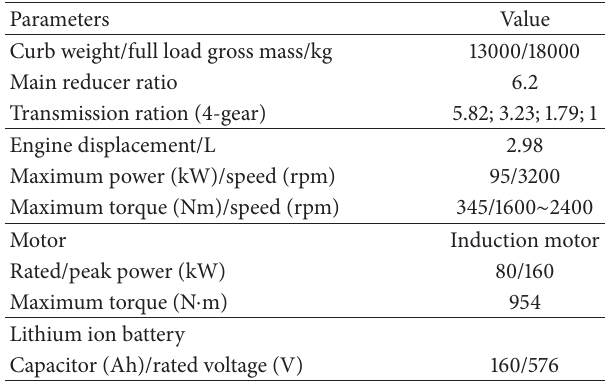
Table 2: The powertrain and vehicle parameters of the PHEB.